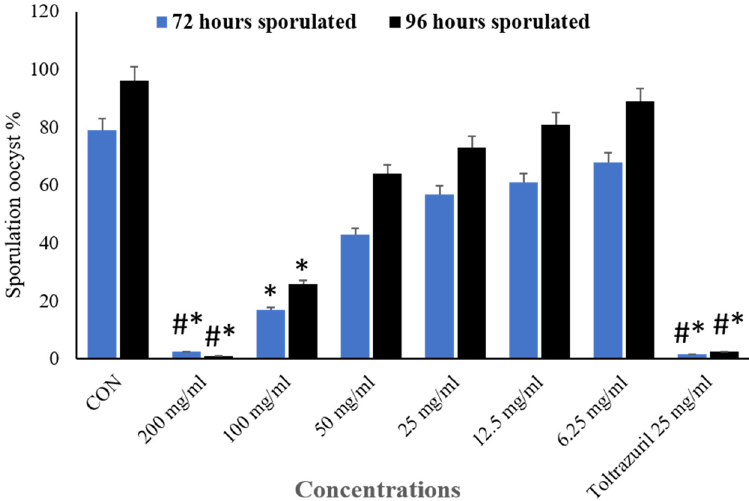
Figure 3: E ff ects of CPLE on oocysts sporulated of E. papillata of concentration at 72 and 96 h in vitro ; CON, control. The signi fi cance was compared to potassium dichromate 2.5% as a negative control and Toltrazuril 25 mg/mL as a positive control. ( *# ) : p - value ≤ 0.001 and ( * ) : p - value ≤ 0.05.